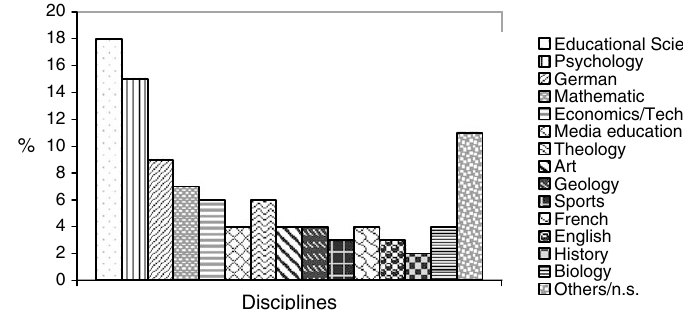
Figure 2. Disciplines using the